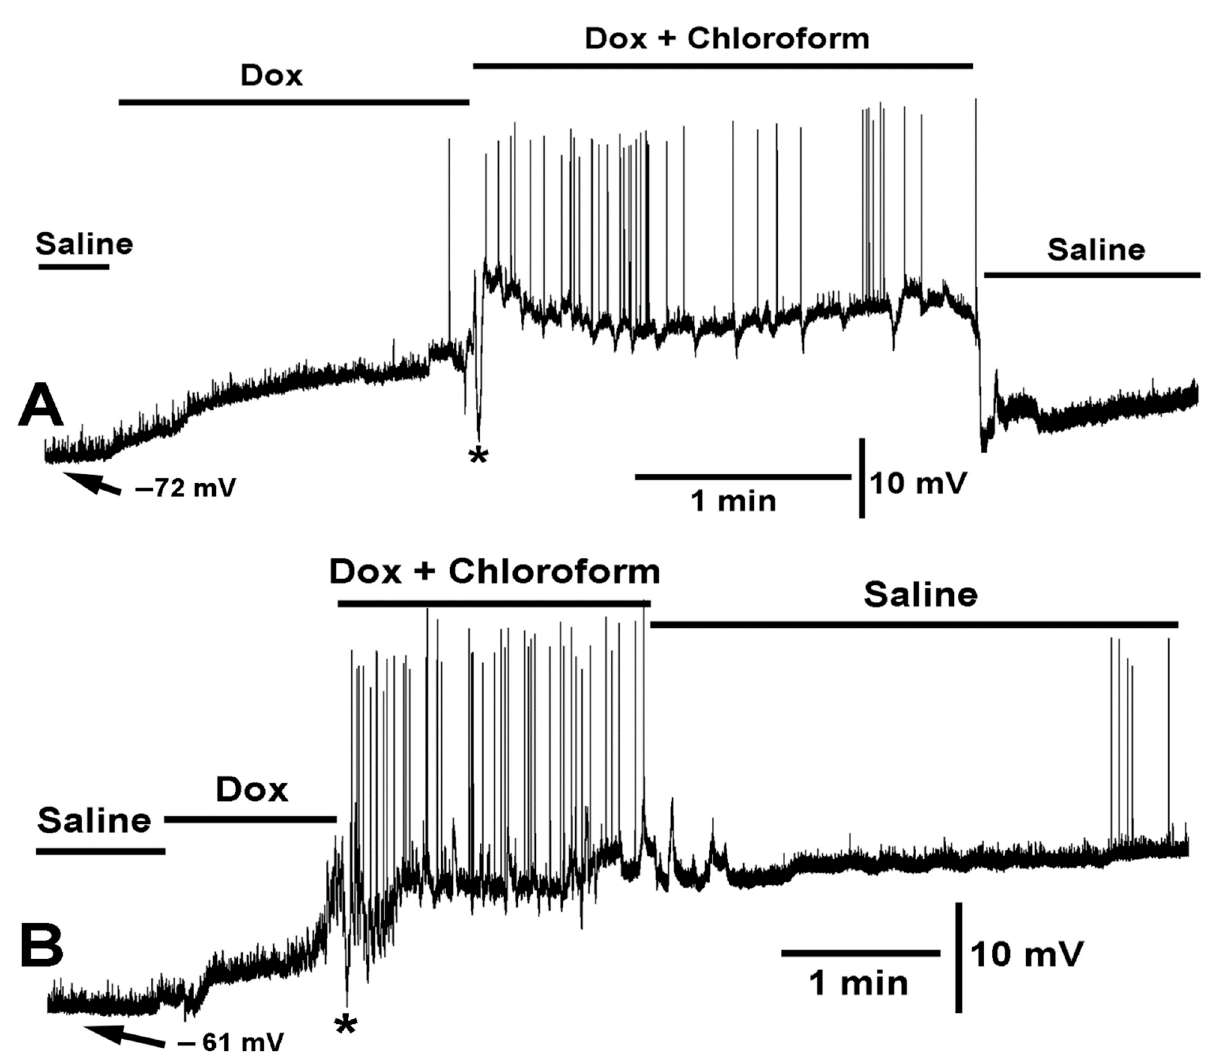
Figure 4. Two variations in the effect of doxapram (10 mM) and the cocktail of doxapram (10 mM) and chloroform (0.2%) are shown. ( A , B ) illustrate two different preparations of the same concentrations of compounds and mixtures. In both variations, doxapram depolarized the membrane potential and upon switching to the cocktail of doxapram (10 mM) and chloroform (0.2%), the membrane rapidly hyperpolarized (<1 s, see asterisks * ) followed with depolarization and doxapram induced EJPs. Exchange to fresh saline recovered the membrane potential in ( A ) but doxapram had a lingering effect in some preparations as shown in ( B ).